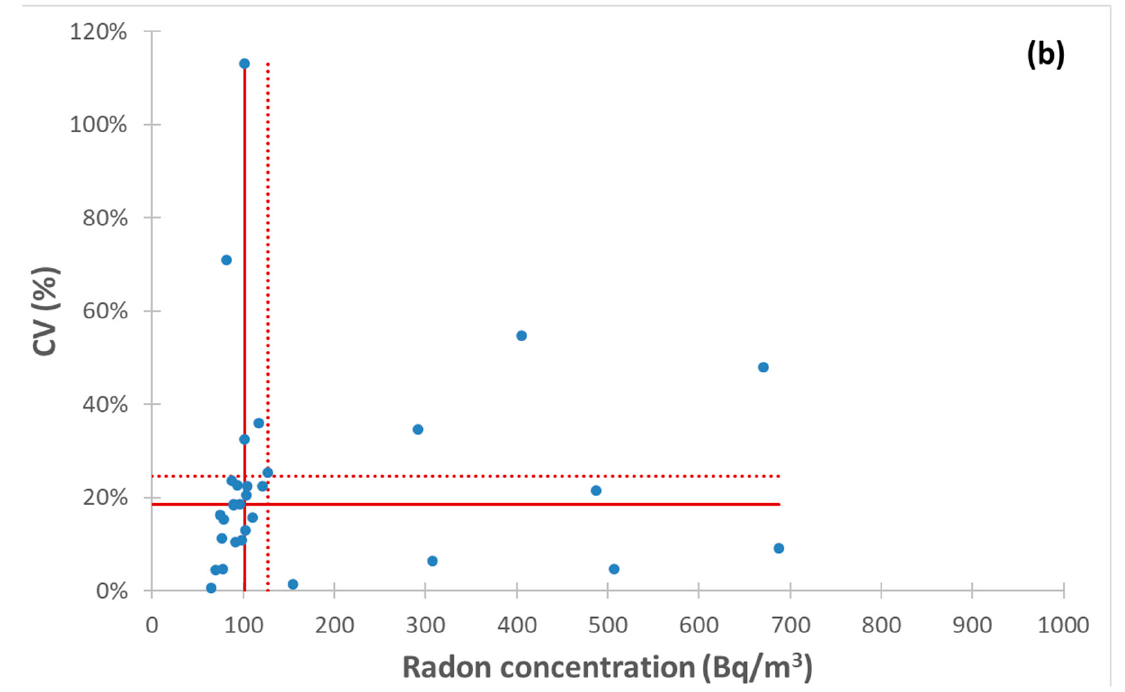
Figure 7. Coefficient of variation (CV) versus annual radon activity concentration (Rn) for each of 51 building ground floors ( a ) and for each of 31 building first floors ( b ). Horizontal continuous and dotted lines intersect axis of ordinates in median and first quartile of CVs distribution (described in Table 4), respectively. Vertical continuous and dotted lines intersect axis of abscissa in median and first quartile of Rn distribution (described Table 3), respectively. The differences between the CVs distribution of panels (a,b) are statistically significant (W-test p = 0.001).